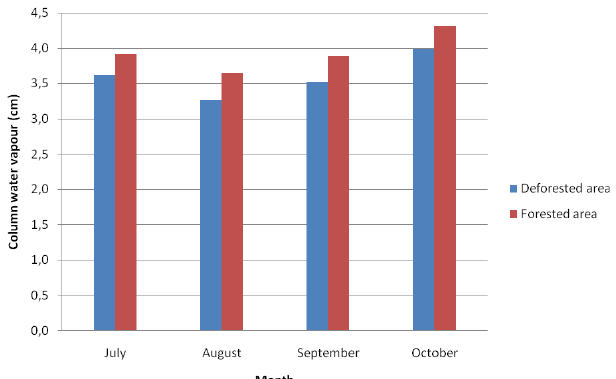
Fig. 7. Column water vapour content retrieved by AERONET sun- photometers at a deforested area (Ji Paran´a – Abracos Hill, located at 10.76 ◦ S, 62.36 ◦ W) and a forested area (Jaru Reserve, located at 10.08 ◦ S, 61.93 ◦ W) from July to October 2002.